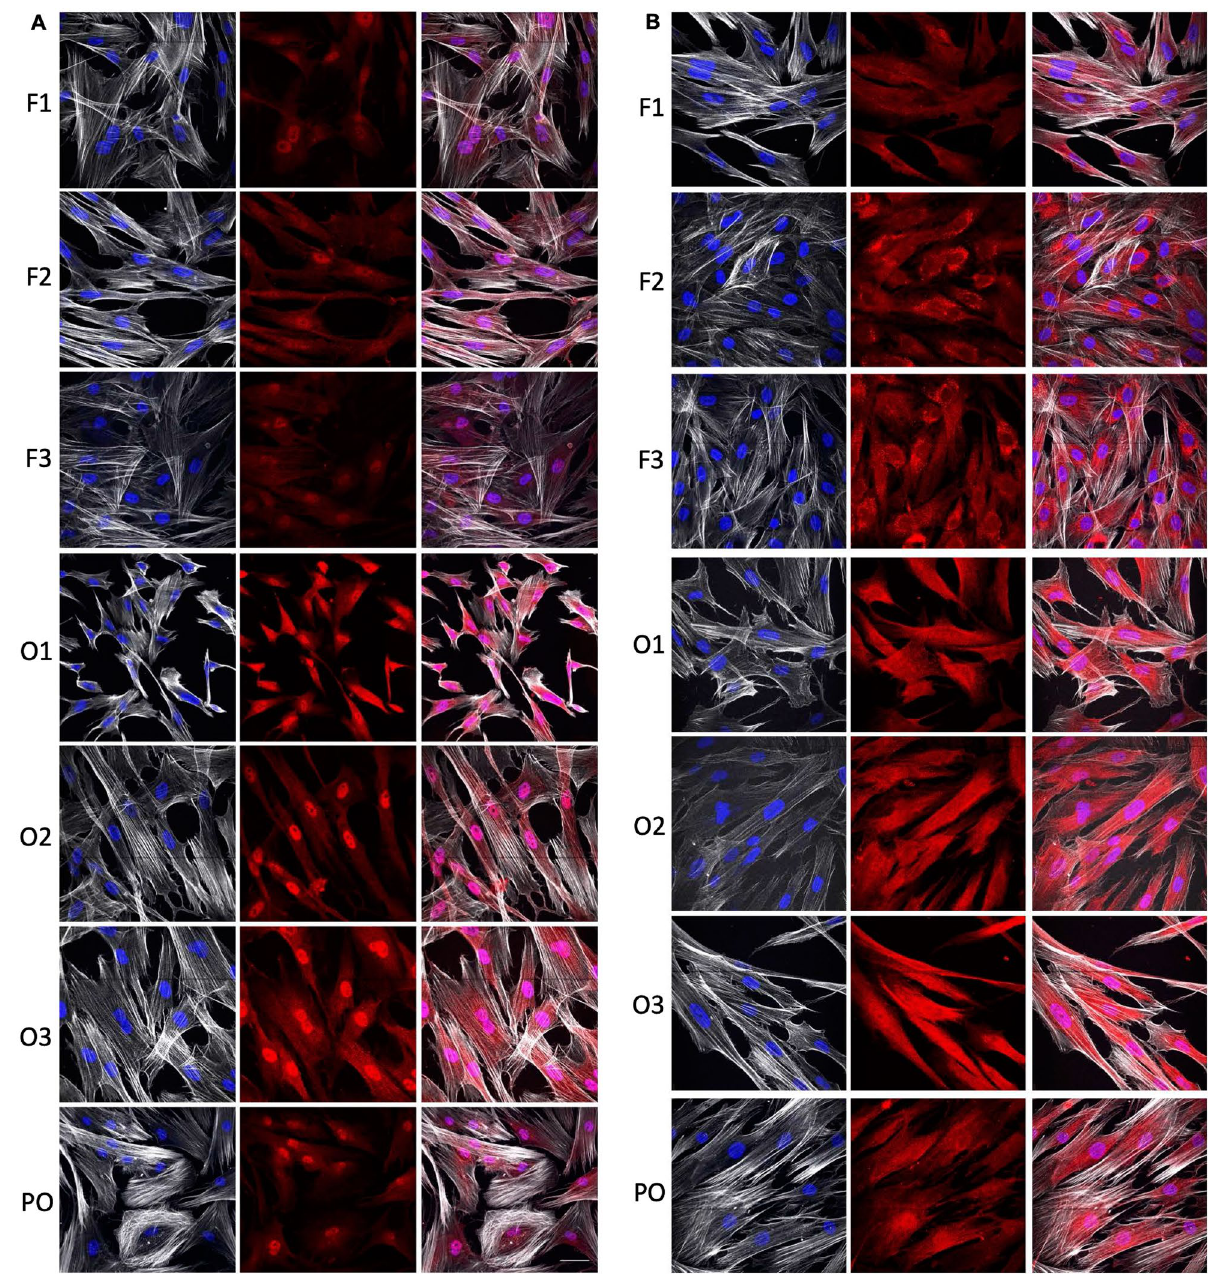
Figure 2. Immunofluorescence staining of RUNX2 and osteocalcin in transdifferentiated osteoblast-like cells. Representative images of 3 primary cell cultures from healthy donors before (F1, F2, F3) and after 21 days of osteogenic transdifferentiation (O1, O2, O3); PO indicates human primary osteoblasts. ( A ) Immunofluorescence staining of RUNX2 in fibroblasts and transdifferentiated osteoblast-like cells. The first column shows DAPI (blue) and phalloidin (white), the second column shows RUNX2 (red), the third column is the merged image of the described two columns and the fourth column is the merged image with a lower magnification. Scale bar is representative of 50 µm. ( B ) Immunofluorescence staining of osteocalcin in fibroblasts and transdifferentiated osteoblast-like cells. The first column shows DAPI (blue) and phalloidin (white), the second column shows osteocalcin (red), the third column is the merged image of the described two